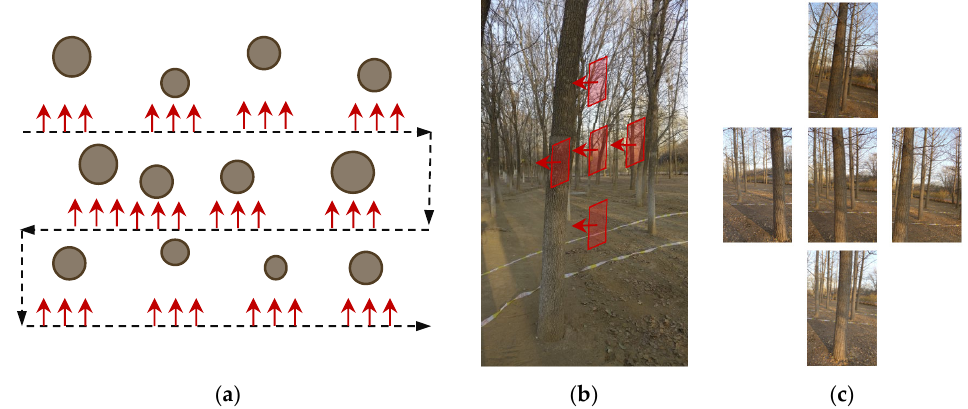
Figure 3. Image collection method. ( a ) A schematic illustration of the photographic path. The circles are trees and the arrows show the directions and positions of images taken along the photographing path indicated by black dash lines. Each tree had three positions for photography: right, middle (where bottom and top pictures were also taken), and left, giving five images per tree. ( b ) A picture demonstrating the viewpoints of five images taken for one tree. The red parallelograms and arrows present the positions and directions of the five pictures per tree. ( c ) Five images taken for a tree in plot 1.